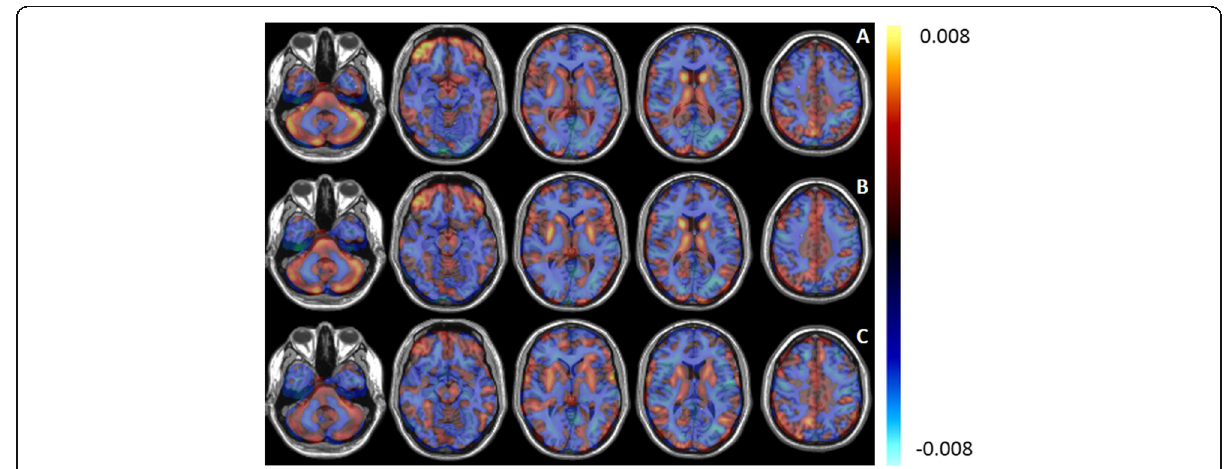
Fig. 3 Discriminative patterns (arbitrary units) between ALS and PP determined by PCA-LR ( a ), PCA-SVM ( b ), and SVM ( c ). The values in each voxel represent the weights of the contribution of the voxel for the classifier. Positive values (red) indicate regions of relative hypermetabolism of ALS patients compared to PP patients, whereas negative values (blue) correspond to relative hypometabolism of ALS patients compared to PP